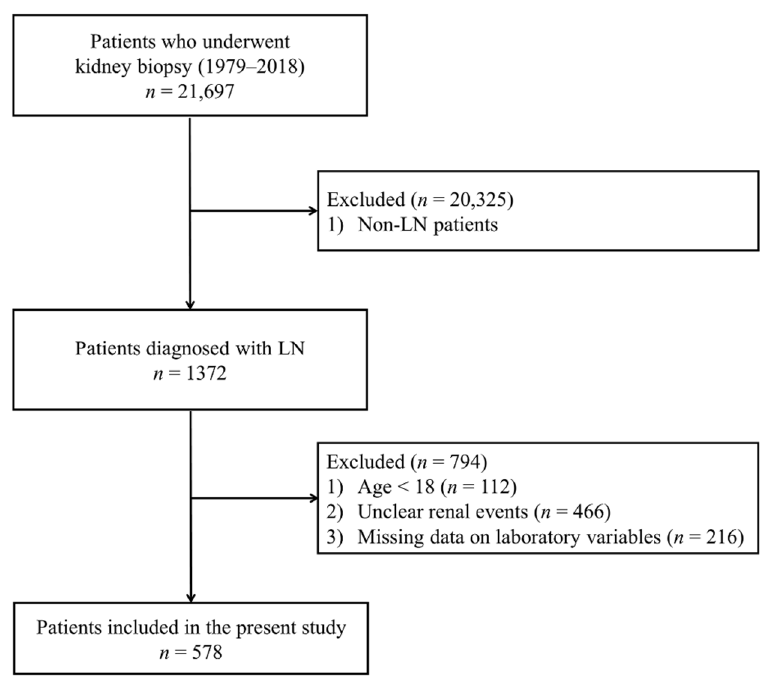
Figure 1. Flow diagram for patient’s enrollment. LN, Lupus nephritis.